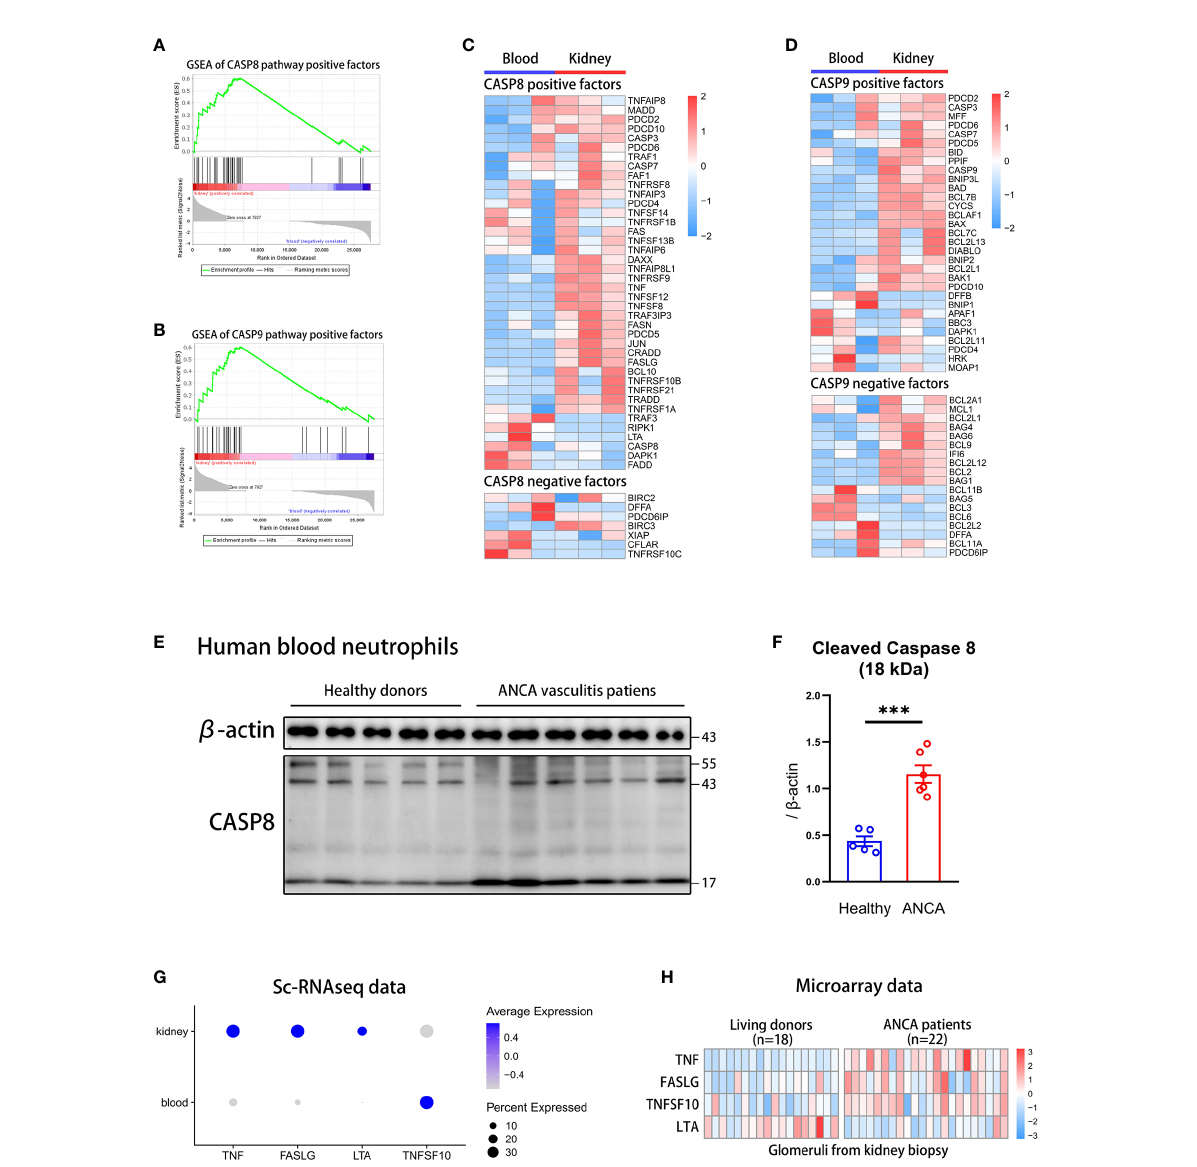
FIGURE 3 The caspase-8 activation in neutrophils is highly correlated with ANCA-associated vasculitis. (A, B) The GSEA plots of positive regulation genes for caspase-8 (A) or caspase-9 (B) pathway in kidney neutrophils. (C, D) The heatmap displaying gene expression for caspase-8 (C) or caspase- 9 (D) pathway regulation in blood and kidney neutrophils. (E) Western blot of caspase-8 in human blood neutrophils from healthy donors and ANCA-associated vasculitis patients. (F) The summary plot comparing levels of cleaved caspase-8 (18 kDa) relative to b -actin between healthy and ANCA groups. (G) The dot plot showing the expression of exogenous positive factors for the caspase-8 pathway in blood and kidney tissues through sc-RNAseq data. (H) The heatmap comparing the expression of exogenous positive factors for the caspase-8 pathway in glomerulis between living donors and ANCA patients through microarray data. ***P <